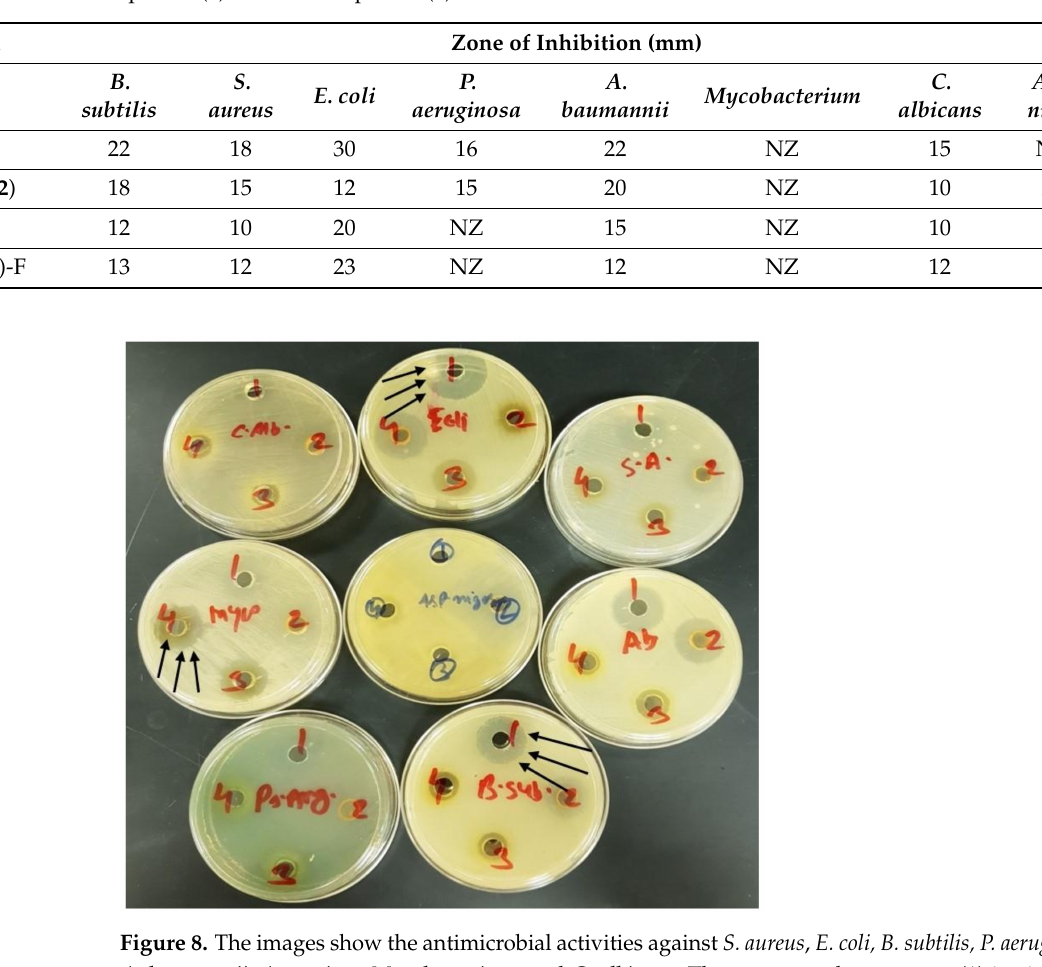
Table 4. Antimicrobial activity of the compound against eight (8) different bacterial strains and measurement of the inhibition zone. NZ = No inhibition zone, compound ( 2 ) = “3-(Naphthalen-1-ylimino)indolin-2-one”, isatin-F = Isatin loaded formulation and compound ( 2 ) and F = compound ( 2 ) loaded formulation.